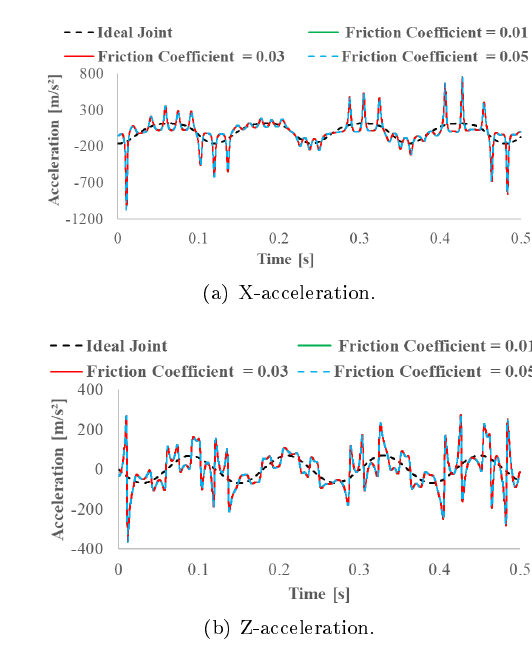
Fig. 10: Accelerations of the 2 nd connecting